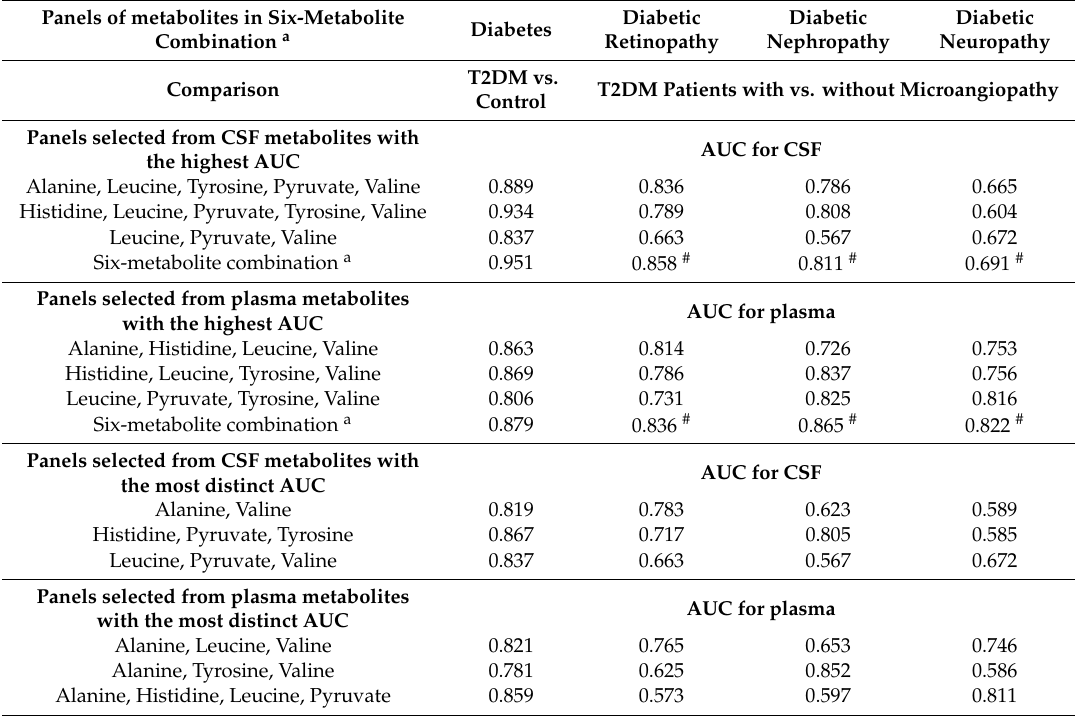
Table 6. Estimated AUC value for multi-marker panels of metabolites in six-metabolite combination for correlation with diabetic microangiopathy.